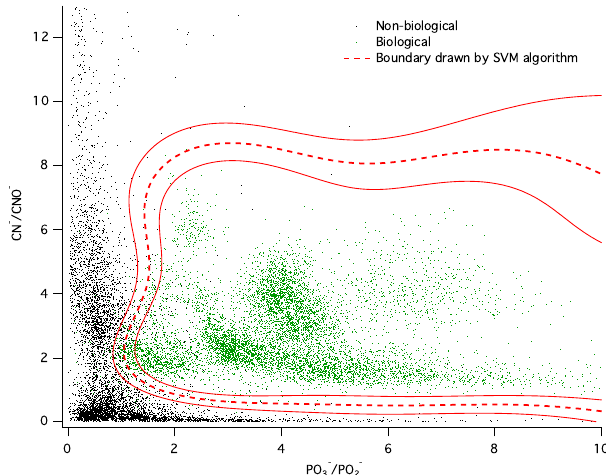
Figure 5. Inorganic and biological particle clusters in / PO − CN − / CNO − vs. PO − space. The SVM algorithm 3 2 “draws” a boundary between the clusters with the red dashed line with an overall 97% classification accuracy. Solid red lines indicate the uncertainty boundary (see text for further